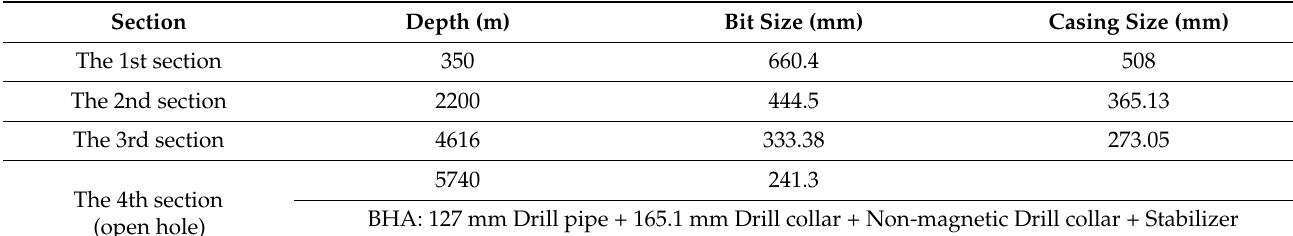
Table 1. Casing programs and the bottomhole assembly for well M.